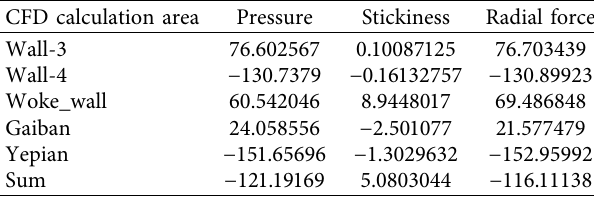
Figure 19: Turbulent kinetic energy stress nephogram. Table 6: Summary of radial force of the plastic centrifugal pump.